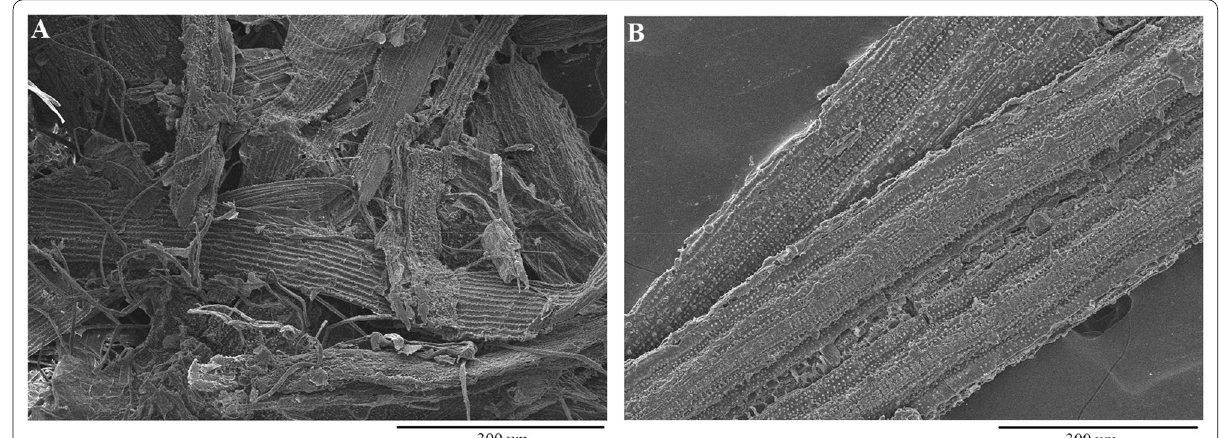
Fig. 2 SEM micrographs of rice straw before ( A ) and after ( B ) pretreatment with 2% NaOH at 80 °C for 5 h